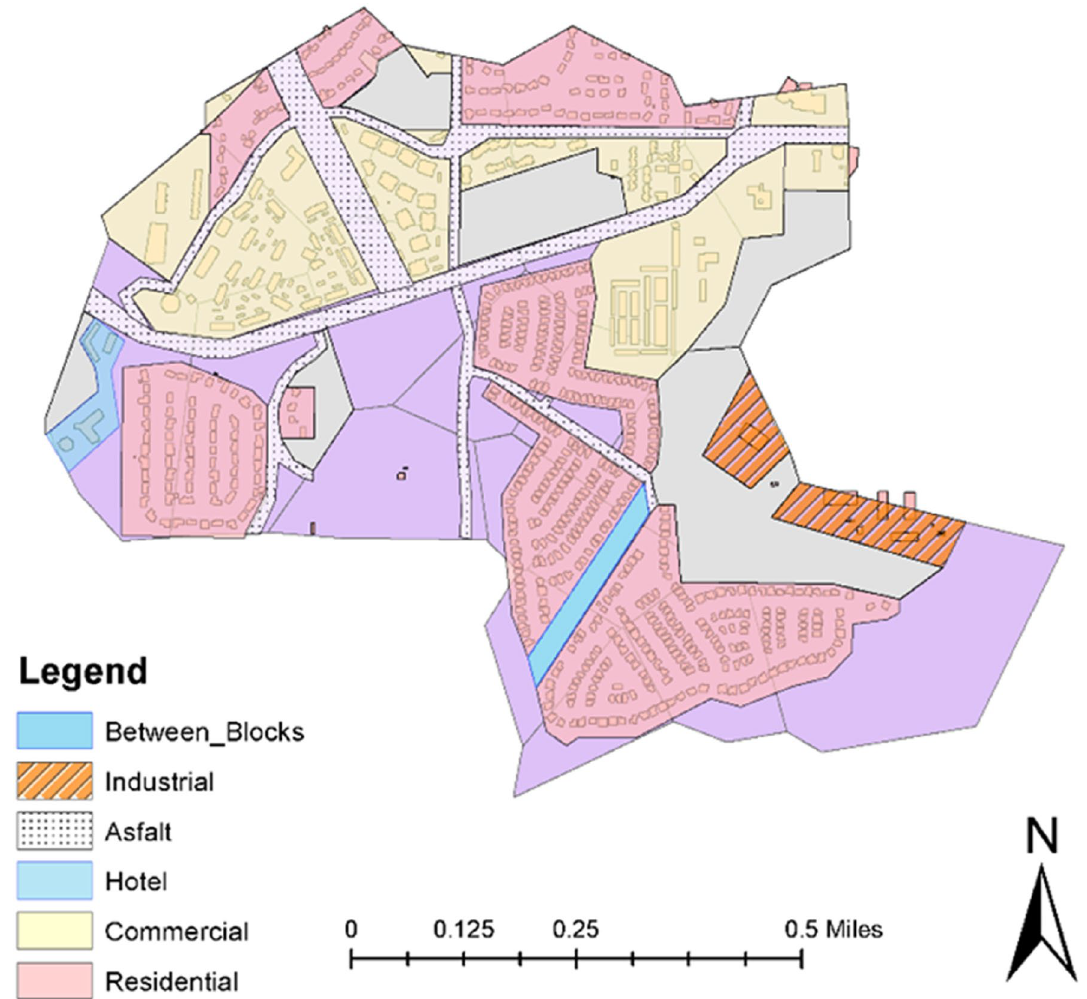
Figure 3. Land use/land cover (LULC) map of Renton city